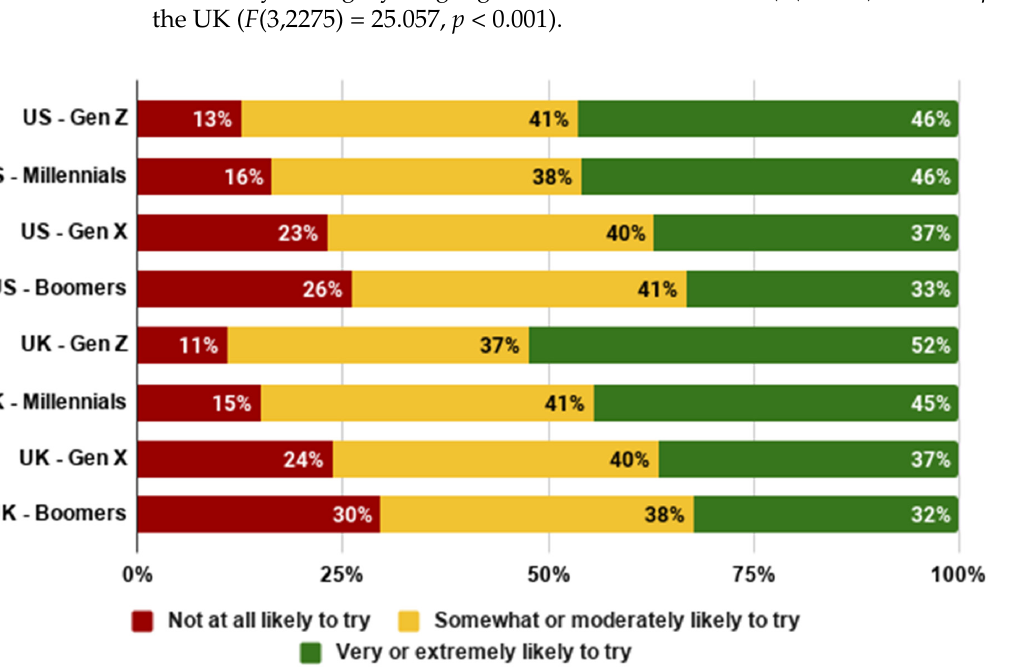
Figure 13. Likelihood of buying cultivated meat by generation. 3.5. Reasons for Dietary Adoption Our next analysis addressed RQ6, and examined consumers’ reported level of im- portance of different reasons for adopting cultivated meat. Details are shown in Figure 14 below.